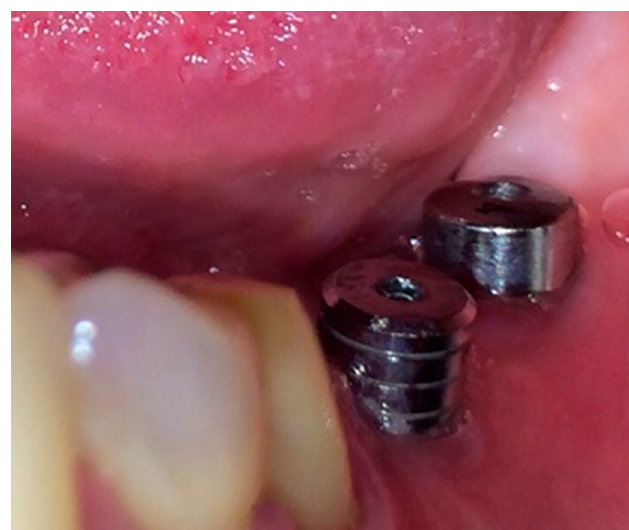
Figure 6. Conventional healing caps in position.